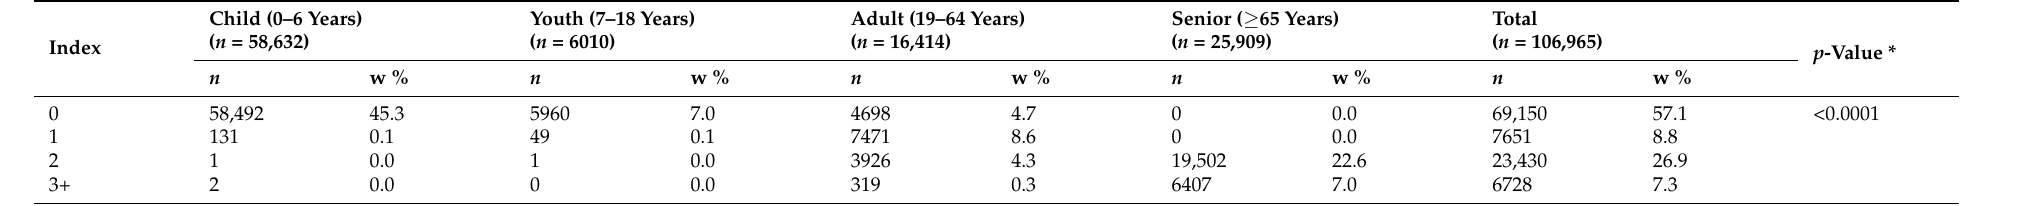
Table 3. The number of discharged pneumonia patients in South Korea according to comorbidity index calculated using Charlson Comorbidity index.